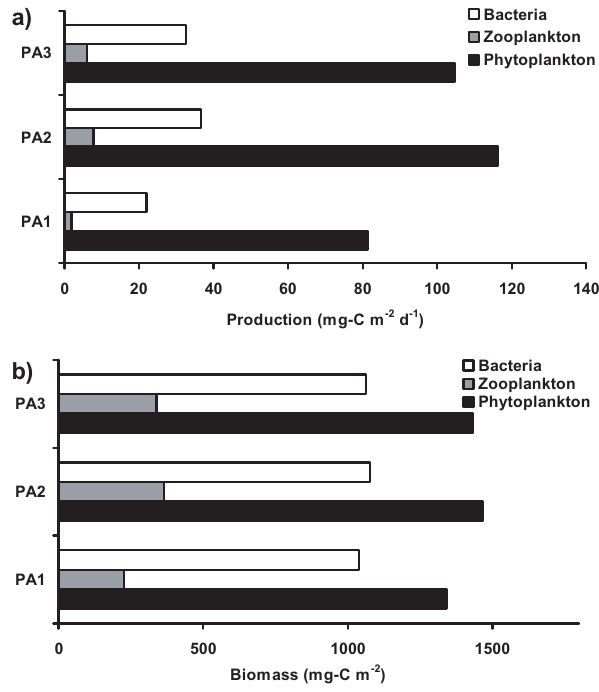
Fig. 8. Annually averaged (a) production and (b) biomass for total phytoplankton, zooplankton and